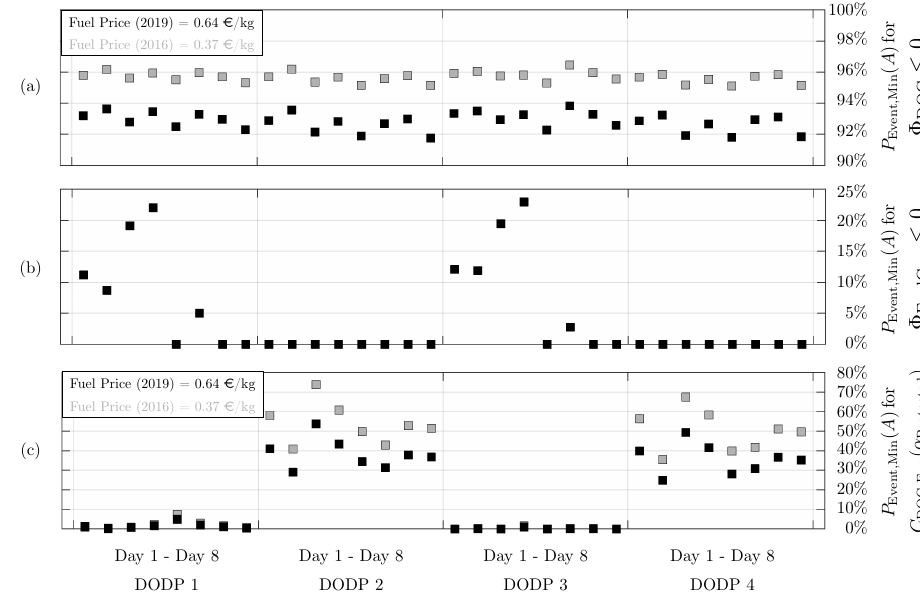
Figure 6. Required success probabilities P ( A ) under operating conditions on the edge of break- even. ( a ) required success probabilities for a monetary break-even condition of AWSE-DPP; ( b ) required success probabilities for a break-even condition of AWSE-DPP in terms of fuel consumption; ( c ) required success probabilities for a monetary break-even condition of AWSE, conducting a conventional fuel